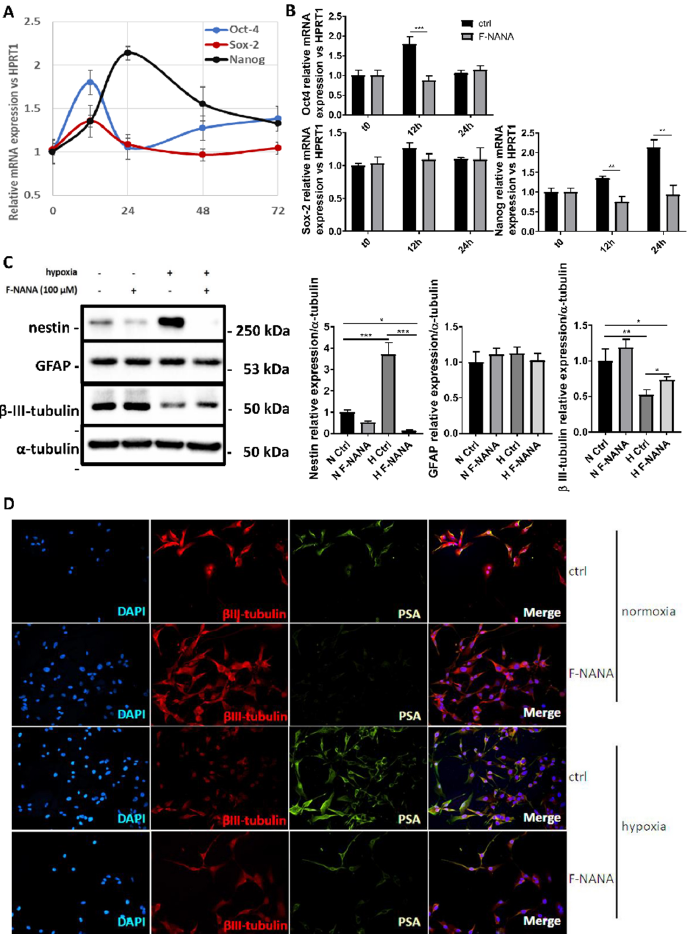
Figure 5. Effect of PSA inhibition on the hypoxia-induced de-differentiation of U87-MG cells. ( A ) Real-time PCR analysis showing the mRNA induction of the stemness genes Oct-4, Sox-2 and Nanog in U87-MG cells grown under hypoxic conditions for 72 h. ( B ) Real-time PCR analysis showing the effect of 100 μ M F-NANA on the expression of Oct-4, Sox-2 and Nanog mRNAs after 12 and 24 h of chronic hypoxia. ( C ) Western blot analysis of the stemness marker Nestin and the differentiation markers GFAP and β III-tubulin in U87-MG cells grown either under normoxia or hypoxia, in presence or not of 100 μ M F-NANA. ( D ) Immunofluorescence analysis showing the expression of β III-tubulin (in red) and PSA (in green) of U87-MG cells grown either under hypoxic or normoxic conditions for 72 h, in presence or not of 100 µ M F-NANA. Nuclei are stained with DAPI (in blue), and merged channels are shown (Merge). Results are presented as the mean ± SD of three independent